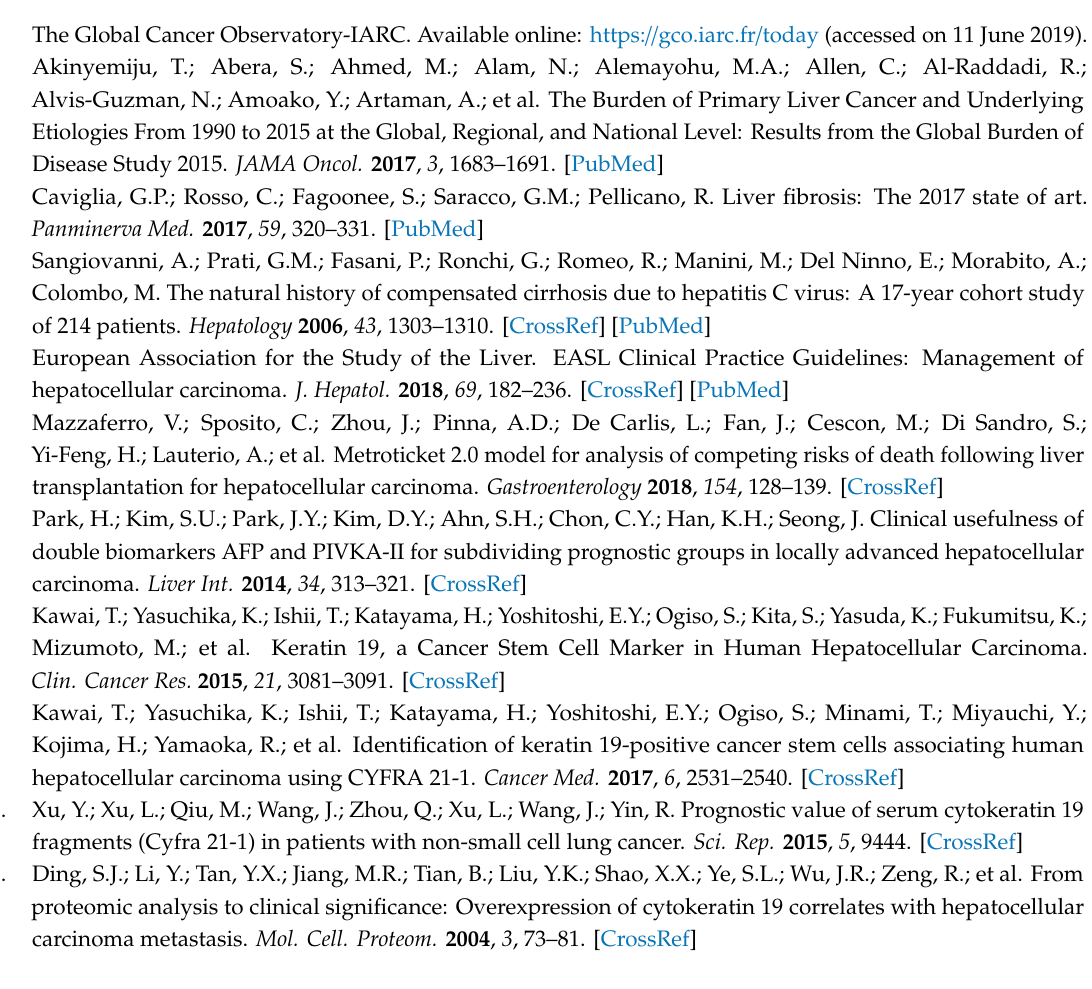
Figure S1: Serum values of CYFRA 21-1 in healthy subjects, patients with cirrhosis without HCC and patients with HCC, Figure S2: Correlation between HCC biomarkers and biochemical